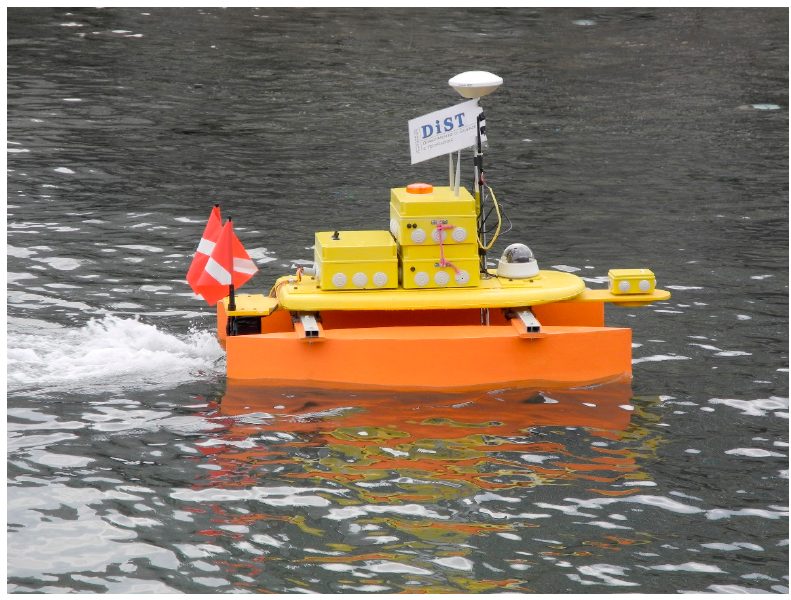
Figure 13. MicroVeGA in action.